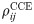
Non-normalized Pearson correlation coefficients ρijCCE and ρijTCE (based on pairwise available data), scaled by w
ij with l
ij = 1 between (a) bilaterally netted current credit exposures and (b) total credit exposures of the banks.